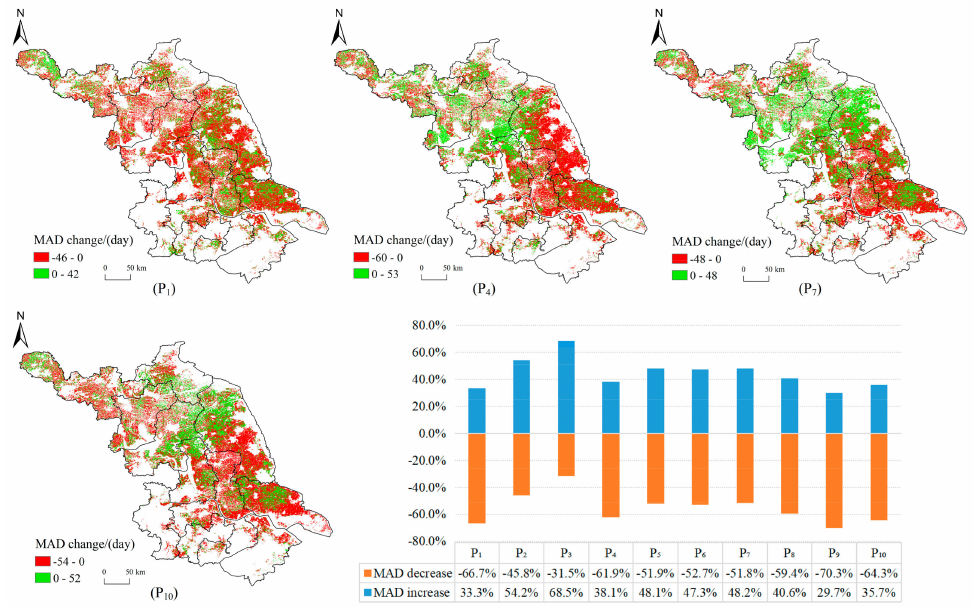
Figure 11. Changes and statistical results of the second crop MAD during a double season. Partial results (P 1 , P 4 , P 7 and P 10 ) are shown. The statistical chart shows that the proportion of cultivated land of the second crop MAD changed from P 1 to P 10 . P 1 : T 2 –T 1 ; P 2 : T 3 –T 2 ; ... ; P 10 : T 11 –T 10.